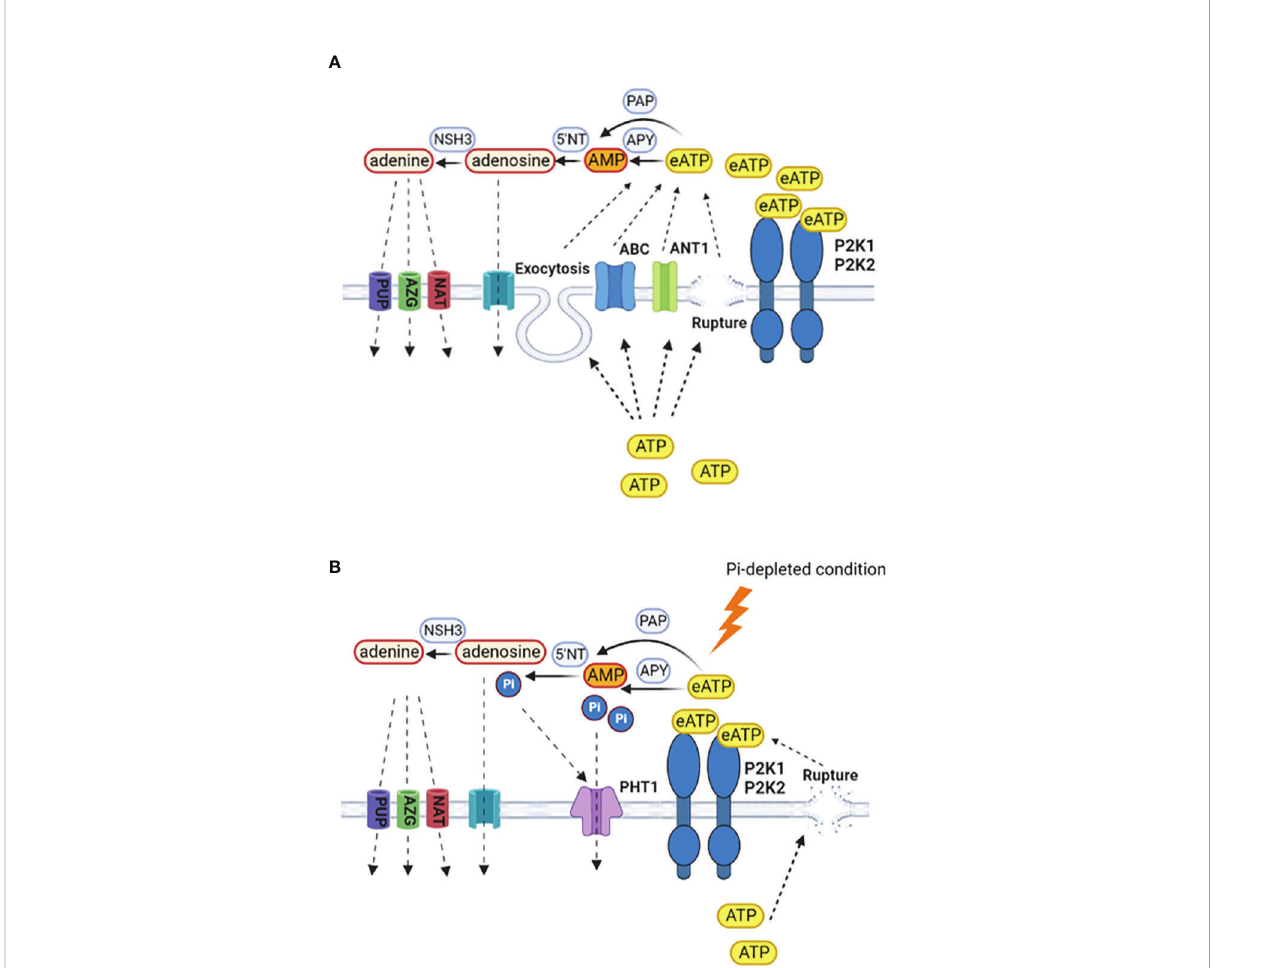
FIGURE 2 Production and scavenging of eATP. (A) In Pi-replete conditions, cytosolic ATP may be released to the extracellular space by wounding, exocytosis or speci fi c transporters such as ANT1 (Thomas et al., 2000; Kim et al., 2006; Rieder and Neuhaus, 2011; Wu et al., 2011). Hydrolysis of eATP to terminate signalling may be by apyrases (APY), purple acid phosphatases (PAP), with subsequent breakdown by 5´nucleotidases and nucleoside hydrolases (Liang et al., 2010; Tran et al., 2010; Tian et al., 2012; Wang et al., 2014; Mehra et al., 2017; Kavka et al., 2021; Zhu S. et al., 2020; Clark et al., 2021). Retrieval of adenosine would be by equilibrative nucleoside transporters and for adenine by purine permeases (PUP), azaguanine resistant proteins (AZG) and nucleobase-ascorbate transporter family members (NAT) (Gillissen et al., 2000; Bernard et al., 2011; Witte and Herde, 2020). (B) Under Pi deprivation, there may be less cytosolic ATP to export and export systems could be limited, with wounding being the predominant route. P2K1 still appears competent but the involvement of P2K2 may be questioned (Matthus et al., 2022). Enzymes involved in eATP breakdown would become part of a Pi salvage system, with Pi uptake by PHT1 high af fi nity transporters that are induced by the PSR. Given the negative role of PHT1.4 in immunity (Dindas et al., 2022), the identities of the PHT1s may be an important control point in determining the resultant balance between nutrition and